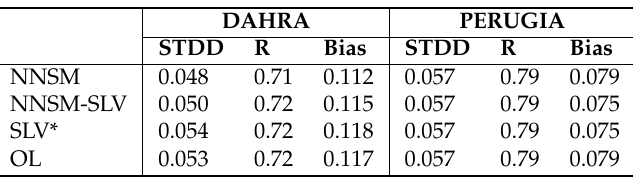
Table 4. Evaluation against in situ measurements. Mean standard deviation of the difference (STDD), Pearson correlation (R) and bias with respect to the in situ measurements for each network of in situ